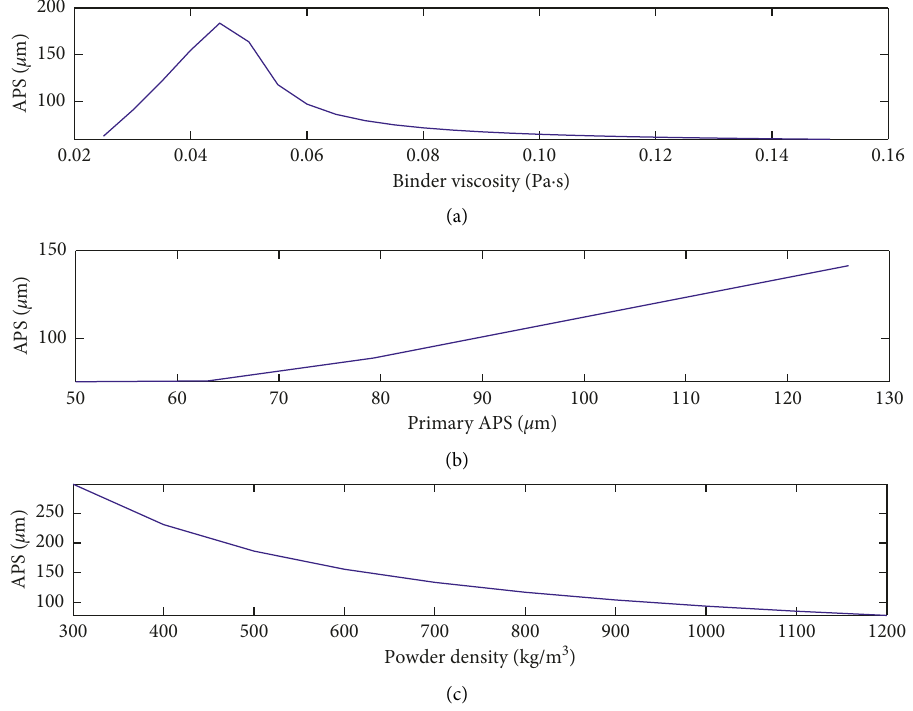
Figure 8: The simulation results for SFBG: influences of material attributes.